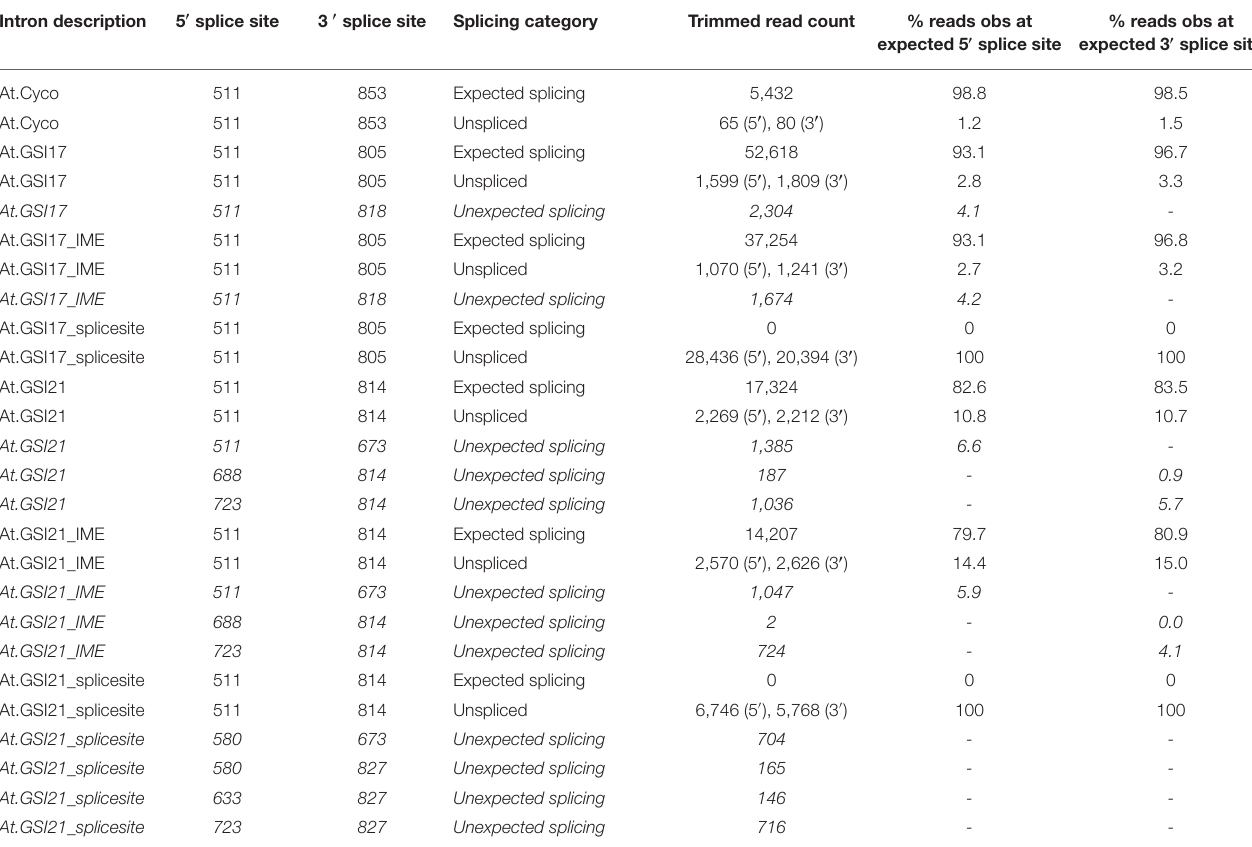
TABLE 2 | GrassRootsIntrons (GSIs) demonstrate predictable splicing that is dependent on functional splicing motifs. Intron description 5 ′ splice site 3 ′ splice site Splicing category Trimmed read